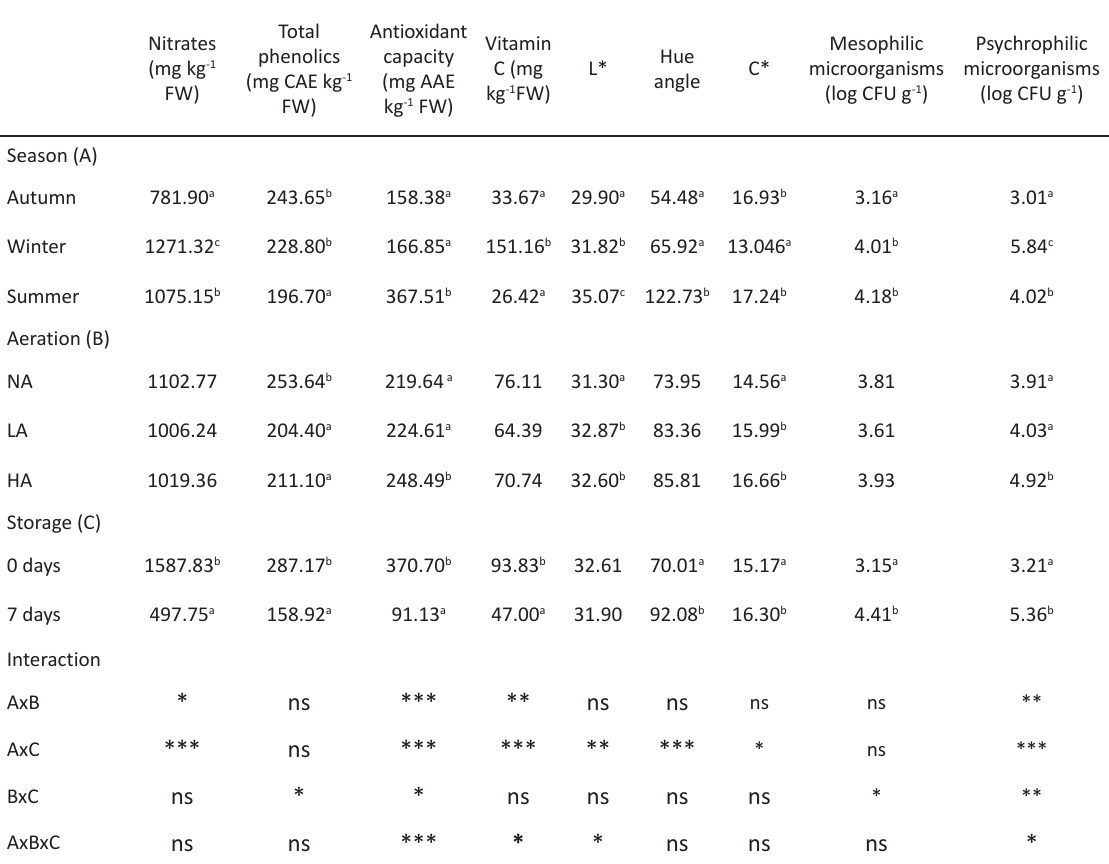
Table 2. Influence of growing cycle (autumn, winter and summer) and aeration of the nutrient solution (no aeration -NA-, low aeration -LA-, high aeration -HA-) on nitrate content, total phenolics, antioxidant capacity, vitamin C, leaf color parameters (lightness -L*-, Hue angle and chromaticity -C*) and microbial growth (mesophilic and psychrophilic microorganisms) of baby leaf red lettuce cultivated in floating system, at harvesting time and after 7 days of storage at 5